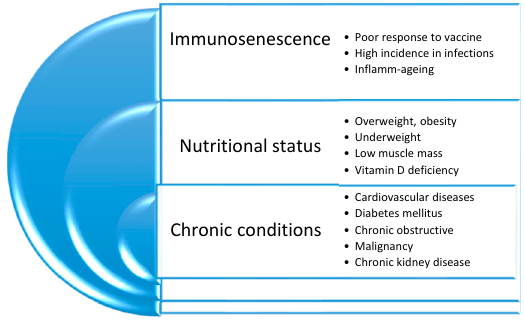
Figure 2. COVID-19 in old age risk Figure 2. COVID ‐ 19 in old age risk factors. Figure 2. COVID ‐ 19 in old age risk factors.